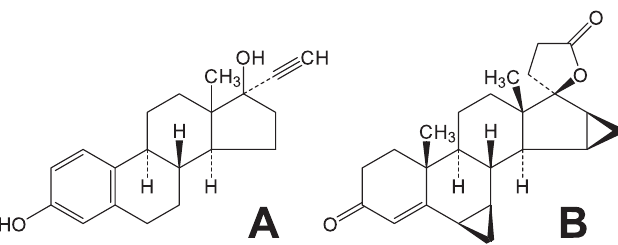
FIGURE 1 - Chemical structures of ethinyl estradiol (A) and drospirenone